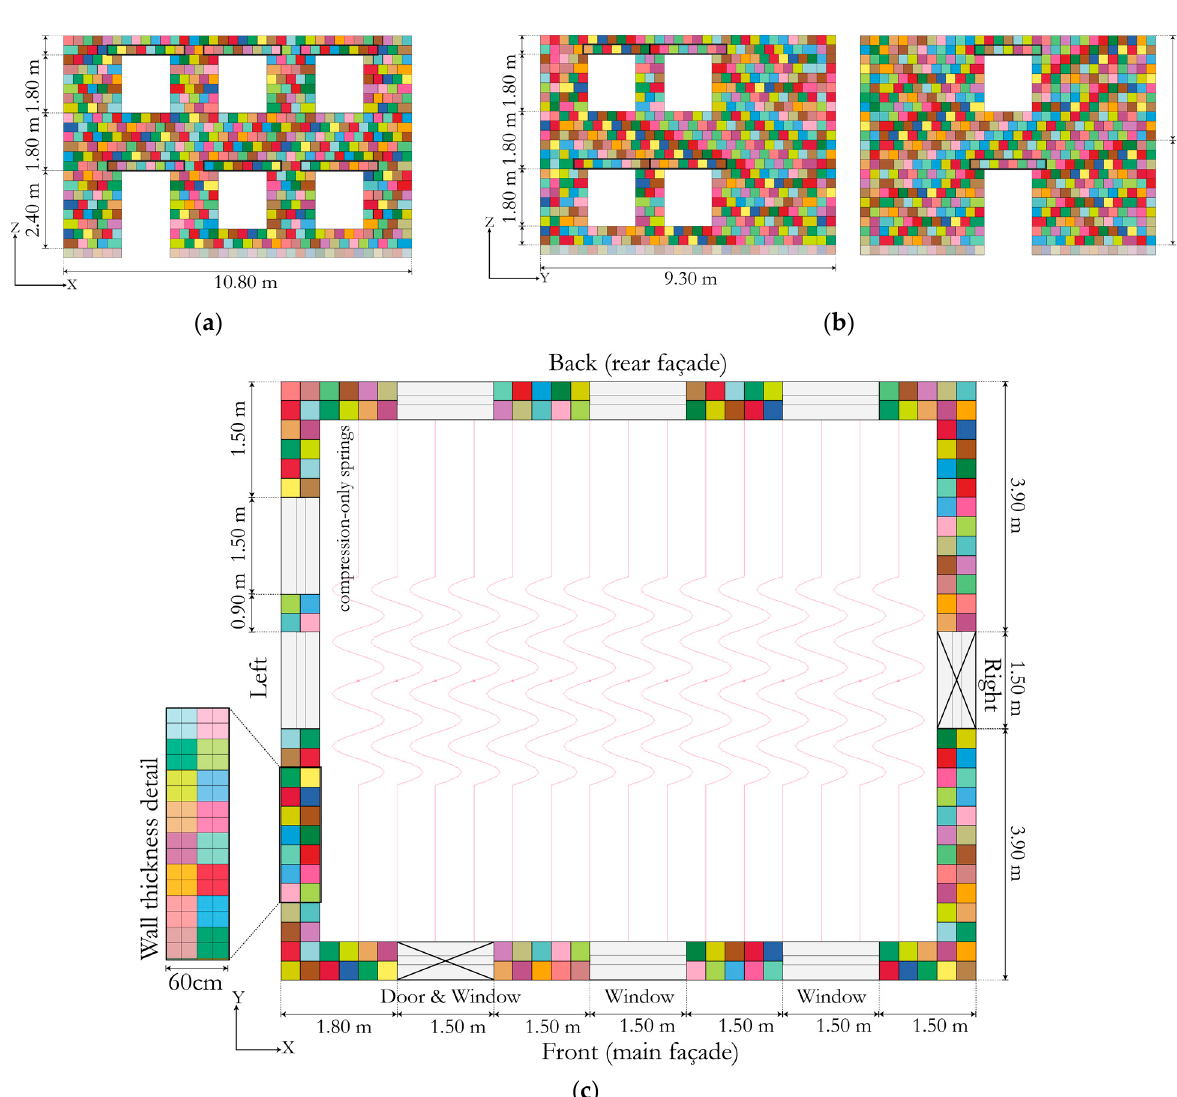
Figure 4. Dimensions of Building 2 and details of the modeling in the LS-DYNA environment: ( a ) elevation view showing the front (main façade); ( b ) elevation view showing the left and right walls; ( c ) plan view of the building and position of compression-only springs (left inset) wall thickness detail.